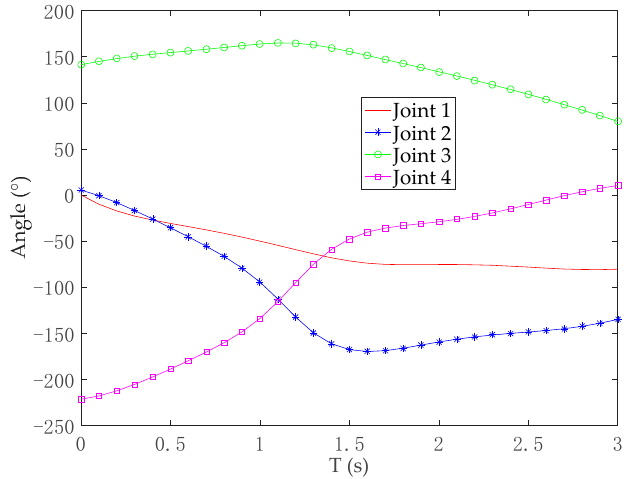
Figure 10. The trajectory of the joint angle in the case of Equation (44).